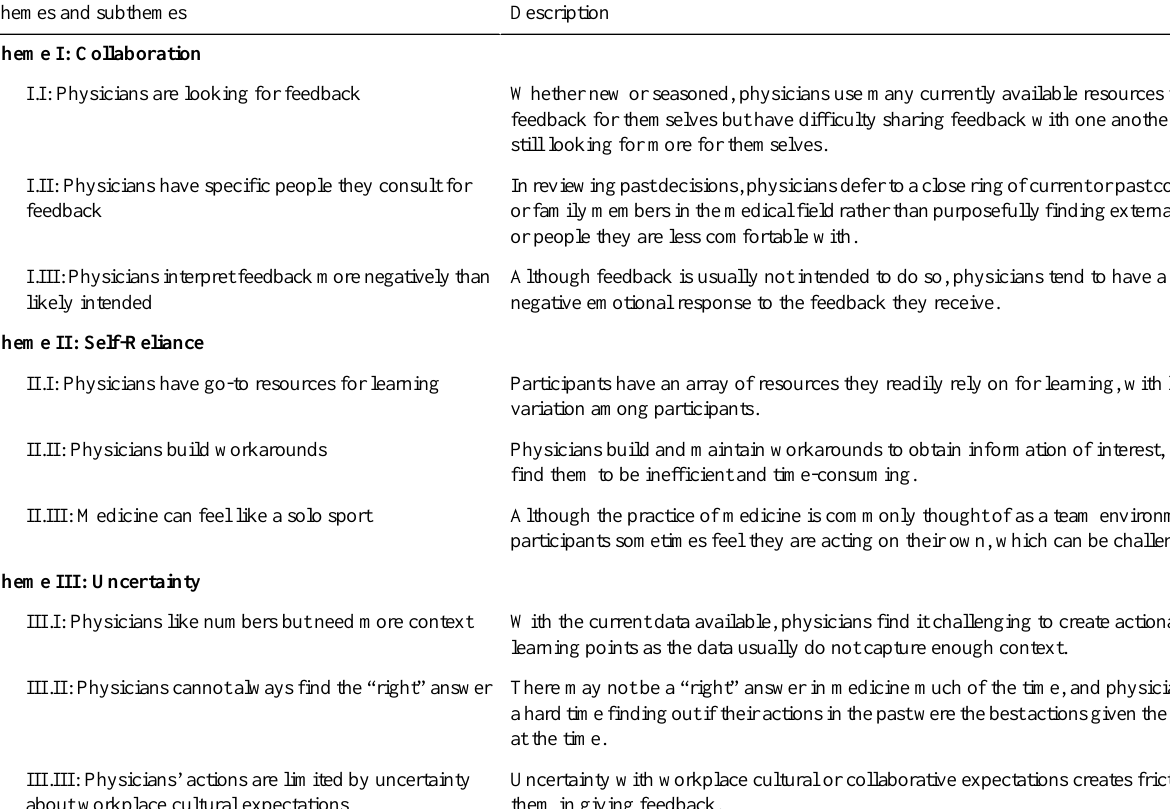
Table 1. Descriptions of themes and